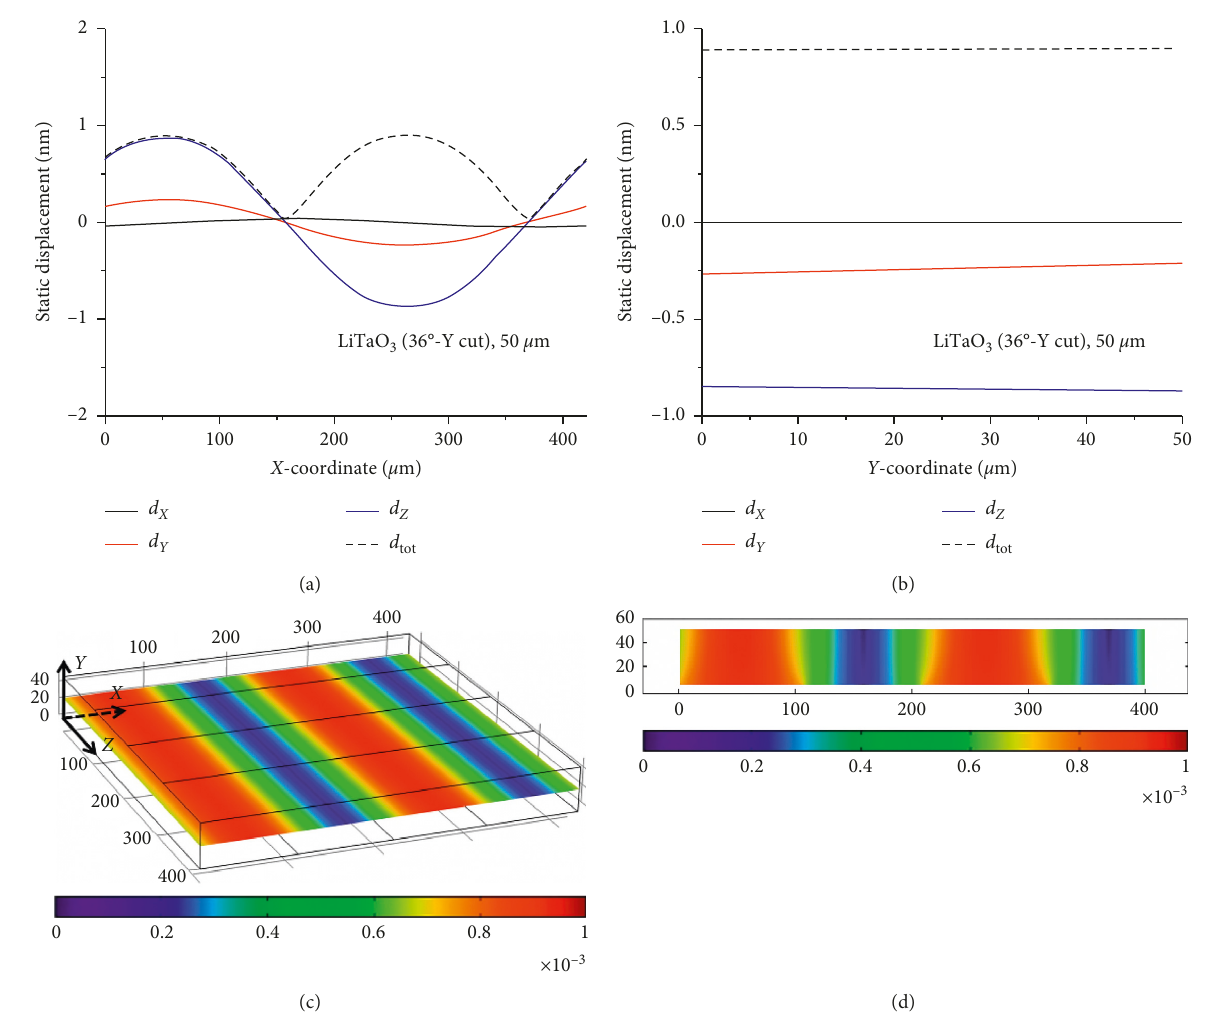
X , d Y , d Z , and d tot components of the static